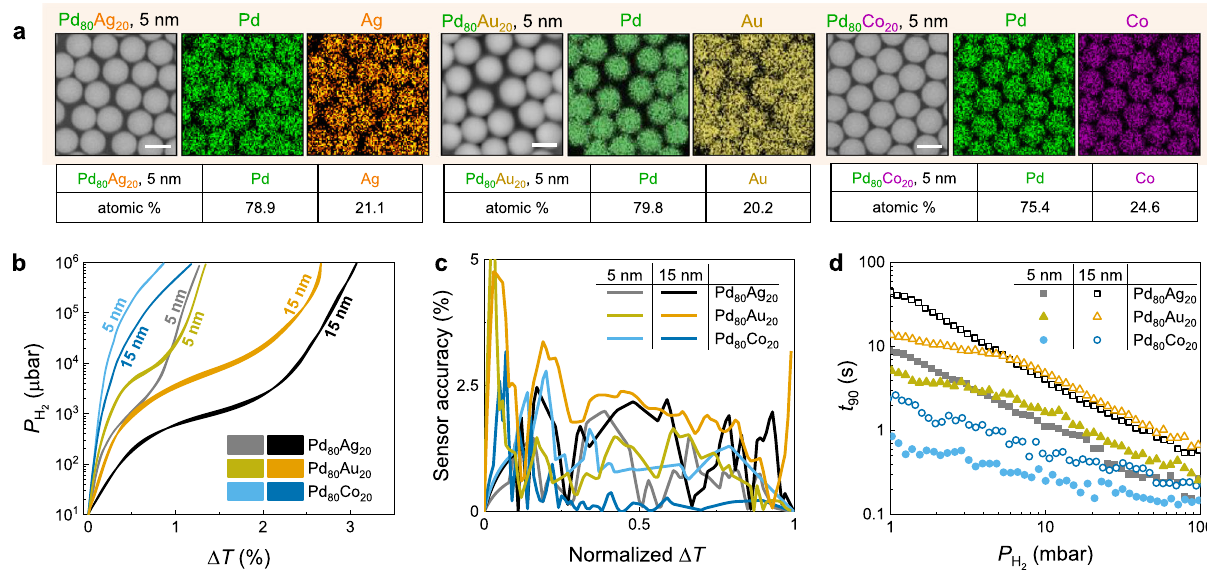
Fig. 4 Composite NP sensors. a SEM and EDS images of Pd 80 Ag 20 , Pd 80 Au 20 , and Pd 80 Co 20 ( t = 5 nm) composite NP samples. Scale bars correspond to 500 nm. Tables show the elemental atomic composition (at. %) of the Pd 80 Ag 20 and Pd 80 Co 20 NPs, which are consistent with the desired compositions. b Optical hydrogen sorption isotherm of composite NP, extracted at Δ T ( λ ) maxima. c Sensor accuracy of composite NP sensors at speci fi c normalized Δ T readout over hydrogen pressure range of 10 1 μ bar to 10 6 μ bar. d Response time of NP sensors with pulse of hydrogen pressure from 1 mbar to 100